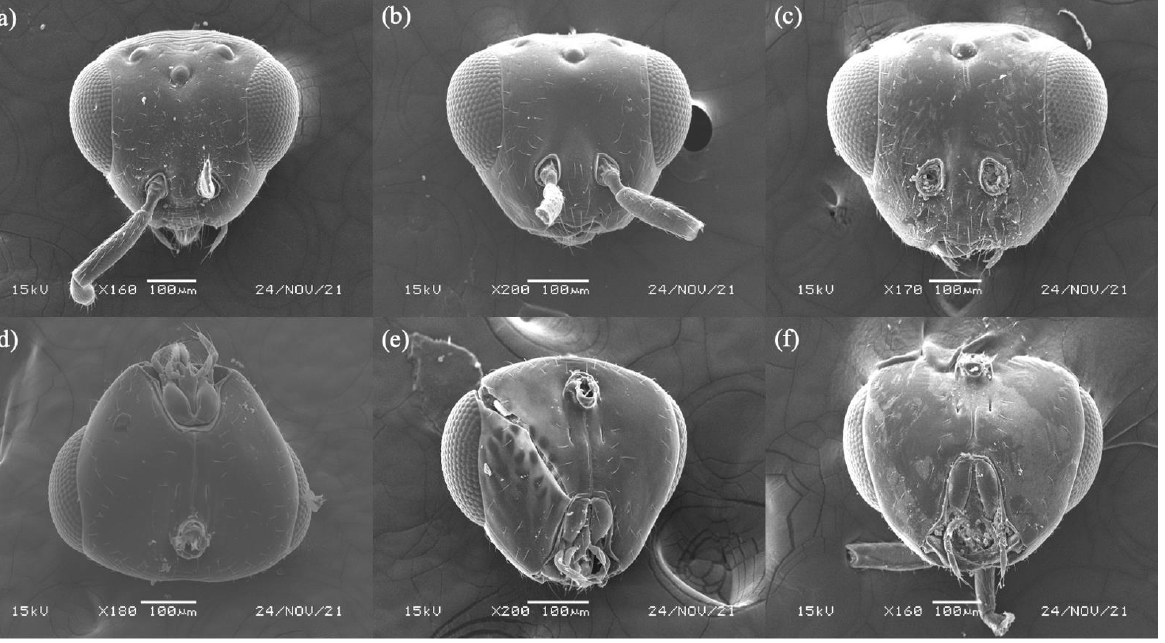
Figure 2. Head, dorsal view of ( a ) Philotrypesis guangdongensis sp. n.; ( b ) P. yunnanensis sp n.; ( c ) P. fujianensis sp. n. Head, ventral view of ( d ) P. guangdongensis ; ( e ) P. yunnanensis ; ( f ) P. fujianensis . Noted that the toruli of P. guangdongensis are located below the bottom line of compound eyes, and the mouthpart of P. fujianensis extended below to the central of compound eyes.